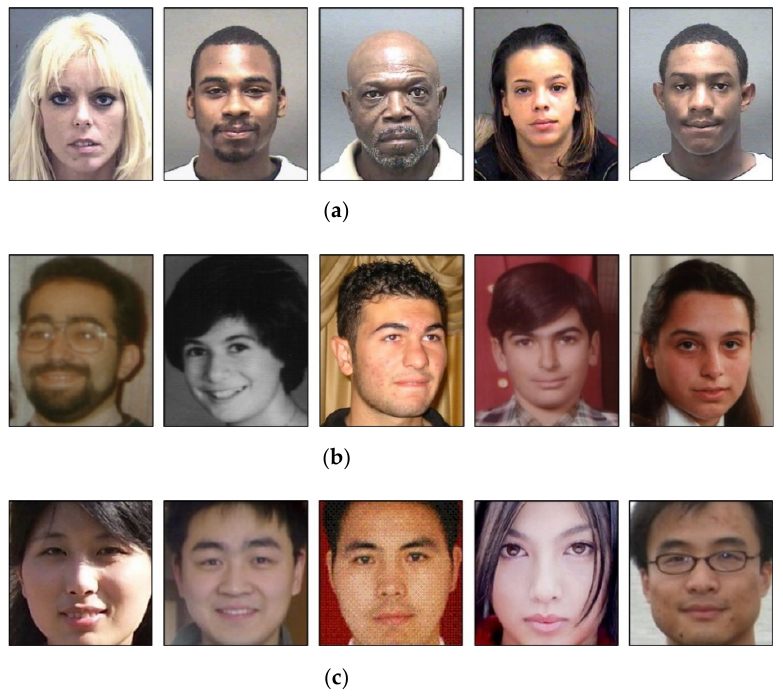
Figure 4. Examples of face image databases. ( a – c ) are examples of the MORPH, FG-NET, and AFAD databases, respectively.